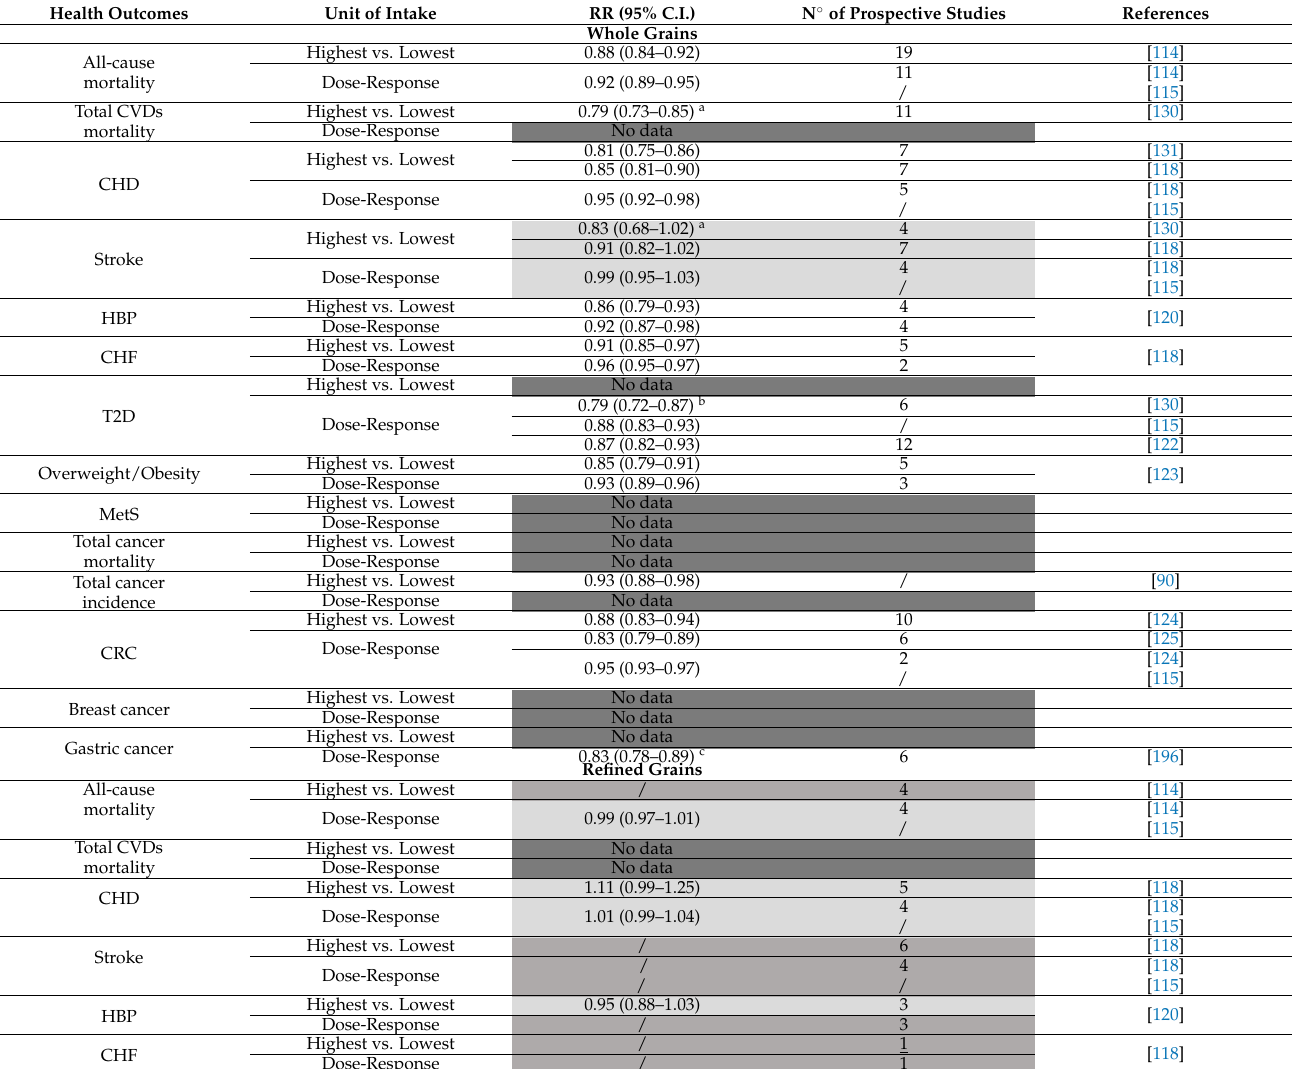
Table 9. Association between whole and refined grains (cereal grains) intake and incidences of some major chronic diseases/mortality of major disease groups (RR, 95% C.I.). The dose-response meta-analysis always refers to an additional serving of a food per day relative to the average intake of that food observed in a cohort study (30 g for whole and refined